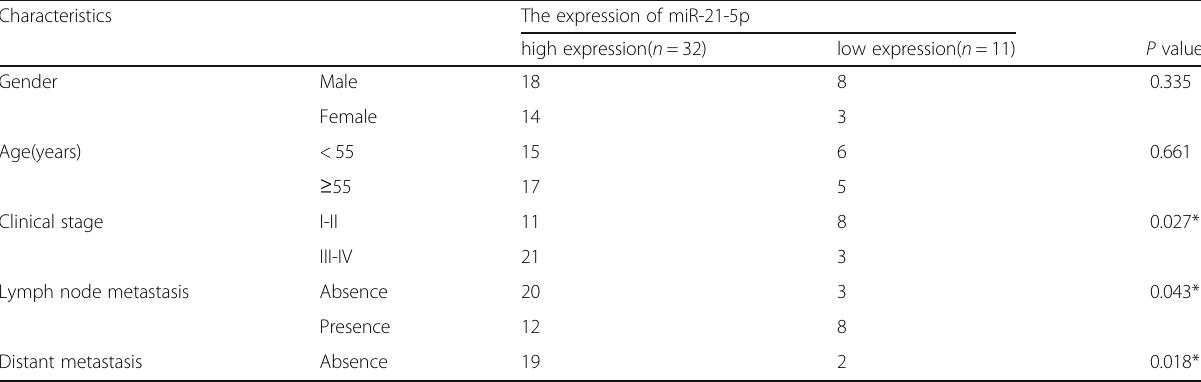
Table 2 Clinicopathological features of COAD patients